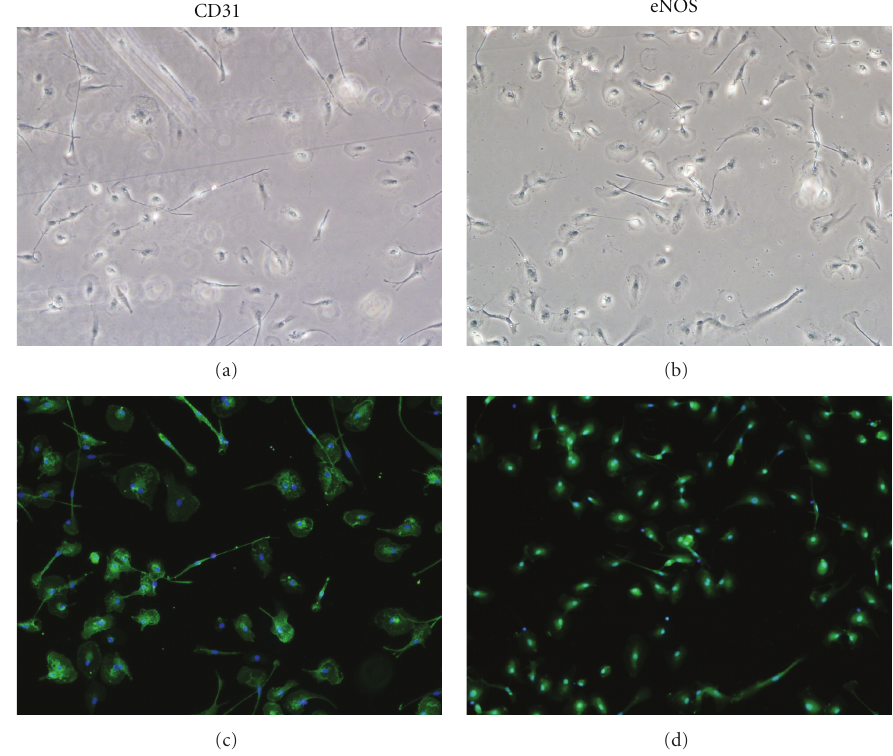
Figure 1: Immunofluorescent staining of cultured mononculear cells for endothelial antigens CD31 and endothelial nitric oxide synthase (eNOS). CD31 and eNOS staining was observed in a subset of cells. A representative sample from a subject with Hemoglobin SS is shown. (a) shows phase contrast image and (c) shows CD31 staining (green) with nuclei stained with DAPI (blue) in the same field. (b) Shows phase contrast and (d) shows eNOS staining (green) for the same